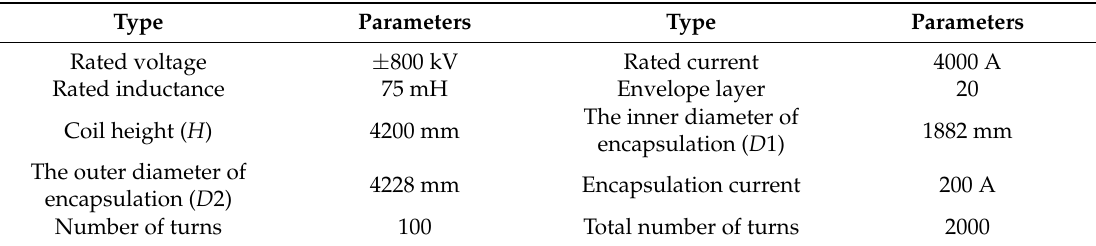
Table 5. Parameters of air reactor.